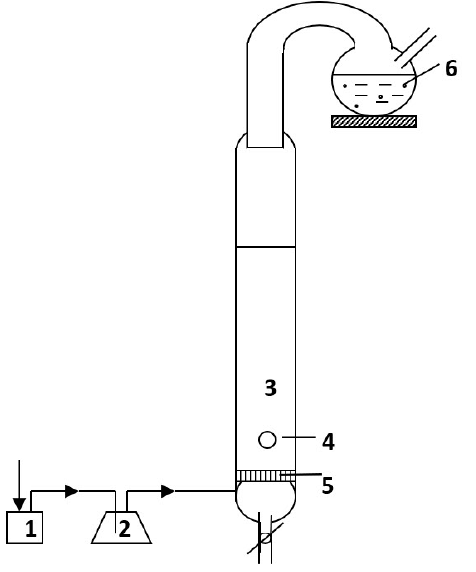
Figure 1. Scheme of ion flotation apparatus. 1—gas flow regulator, 2—aqueous scrubber, 3—flotation column, 4—injection capable valve (for collector), 5—sintered glass sparger, 6—foam receiver.